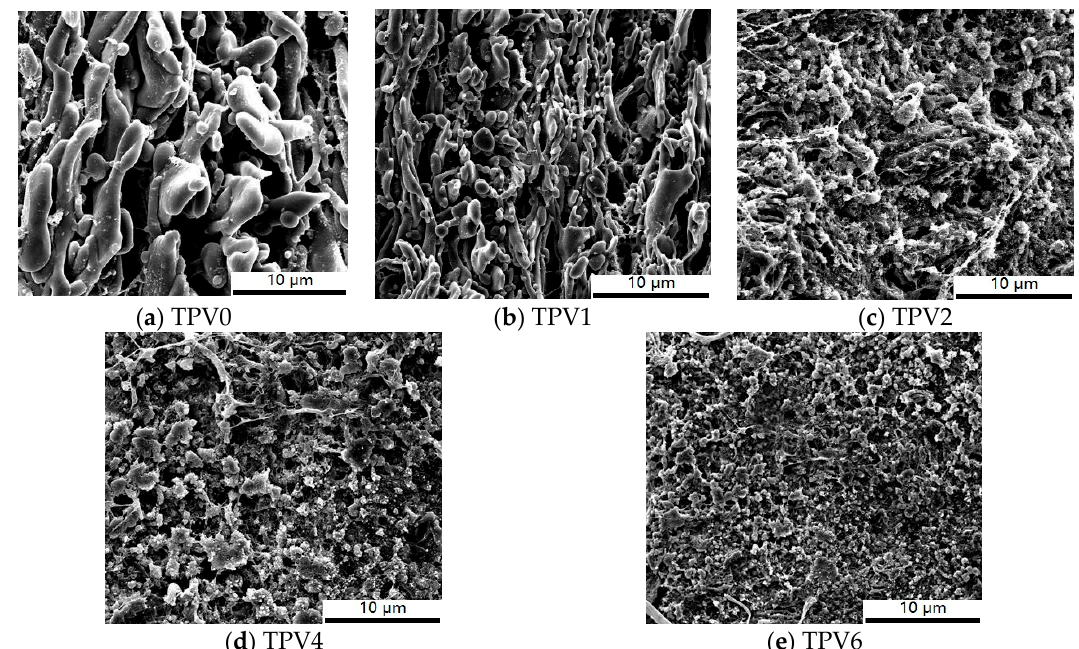
Figure 4. Typical TEM images of TPV0, TPV1, TPV2, TPV4 and TPV6 samples.